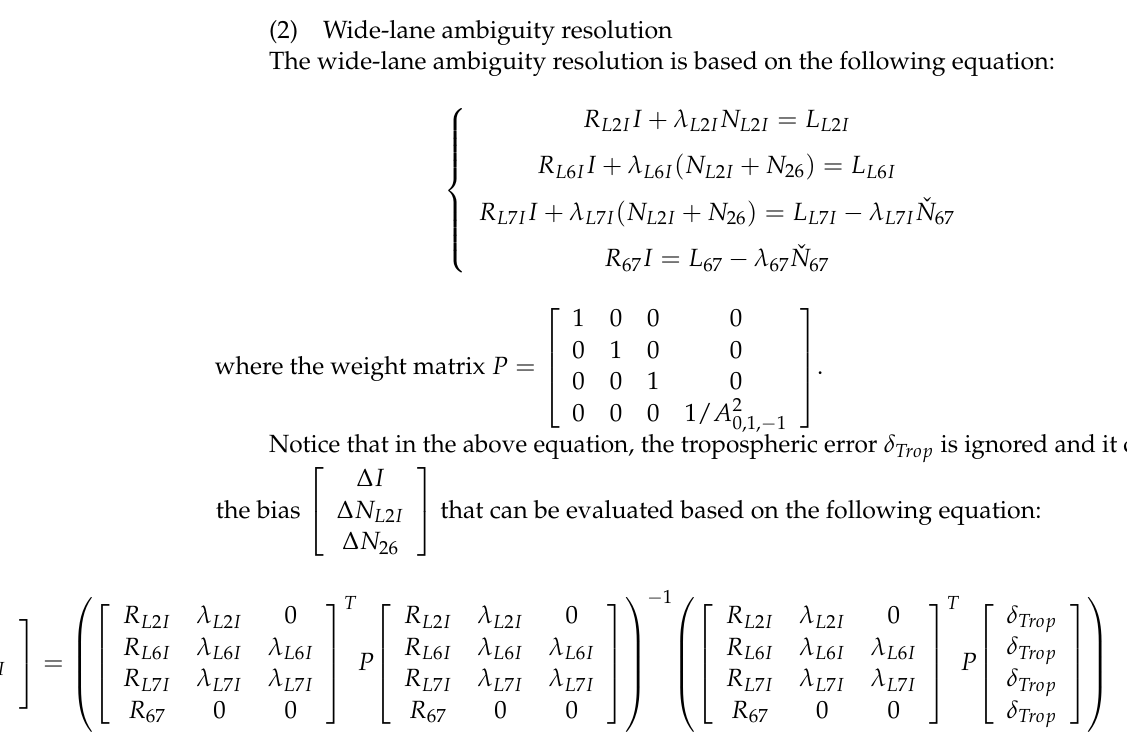
Figure 2. Extra-wide lane ambiguity minus correct integer ambiguity (BDS).